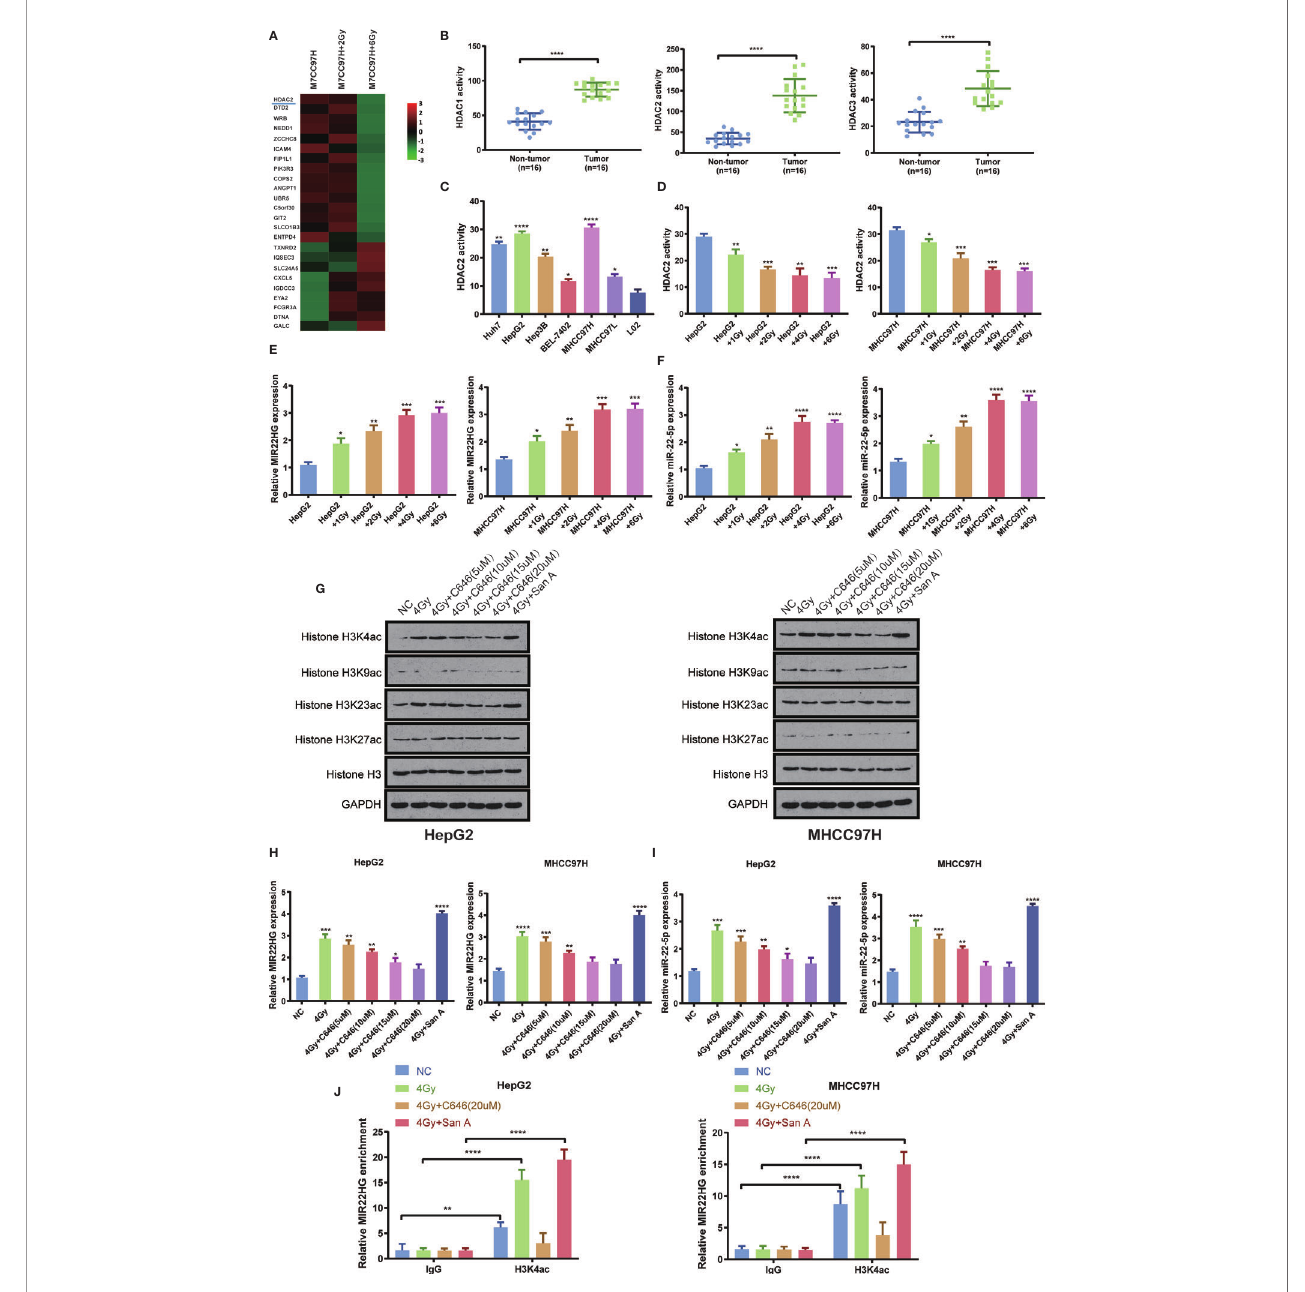
FIGURE 2 | (A) Microarray results indicating that HDAC2 expression in MHCC97H cells decreased signi fi cantly after irradiation. (B) HDAC1, HDAC2, and HDAC3 activity in tumor (n = 16) and non-tumor (n = 16) tissues. (C) The activity of HDAC2 in the HCC cells Huh7, HepG2, Hep3B, BEL-7402, MHCC97H, and MHCC97L and the human normal liver cells L02. *Compared with the L02 group. (D) The activity of HDAC2 in HepG2 and MHCC97H cells treated with different doses of irradiation. * Compared with the HepG2 and MHCC97H groups. (E, F) The mRNA expression of MIR22HG and miR-22-5p in HepG2 and MHCC97H cells treated with different doses of irradiation (1, 2, 4, and 6 Gy). *Compared with HepG2 and MHCC97H groups. (G) Western blot analysis of histone H3K4ac, H3K9ac, H3K23ac, H3k27ac, and H3 in HepG2 and MHCC97H cells. The treatments were irradiation of 4 Gy alone, irradiation of 4 Gy + histone acetyltransferase inhibitor C646, irradiation of 4 Gy + histone deacetylation inhibitor Santacruzamate A. (H, I) Expression of MIR22HG and miR-22-5p in HepG2 and MHCC97H cells. The treatments were irradiation 4 Gy alone, irradiation of 4 Gy + histone acetyltransferase inhibitor C646, irradiation of 4Gy + histone deacetylation inhibitor Santacruzamate A. * Compared with the NC group. (J) ChIP-PCR showing the ampli fi ed signal of the MIR22HG promoter region. The treatments were irradiation of 4 Gy alone, irradiation of 4 Gy + histone acetyltransferase inhibitor C646, and irradiation of 4 Gy + histone deacetylation inhibitor Santacruzamate A. Results showed that both irradiation and drug intervention in HDAC2 can alter ampli fi ed signals of the MIR22HG promoter region. Mean ± SD (n = 3 independent experiments). * p < 0.05, ** p < 0.01, *** p < 0.001, **** p < 0.0001. San A, Santacruzamate